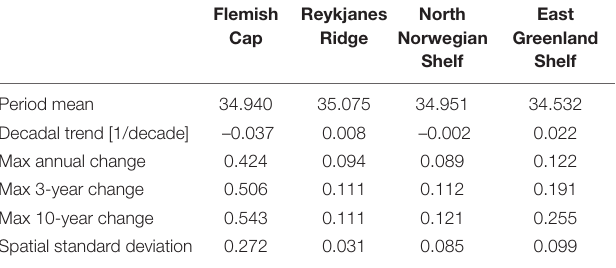
TABLE 4 | Summary of salinity properties at the four sponge habitats in waters with bottom depth 200–700 m: period mean, decadal trend, the maximum change in the monthly mean over a period of 12, 36 months, and 10 years, and the temporal mean of the spatial standard